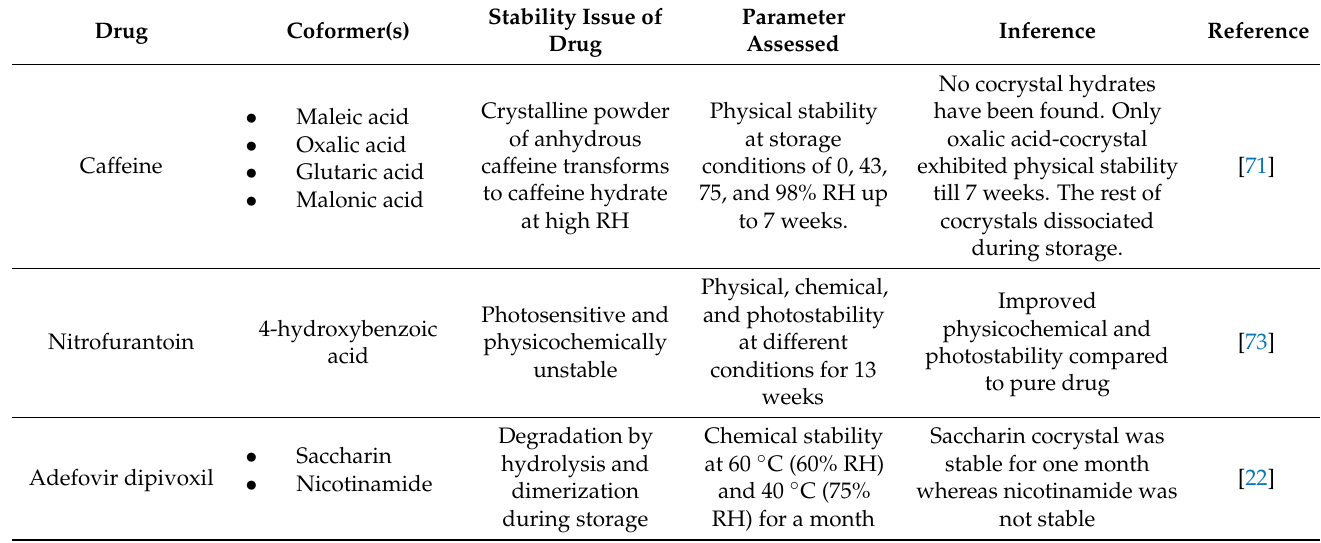
Table 3. Examples of studies reporting on coformers’ effect on stabilization of drug molecules in cocrystals.